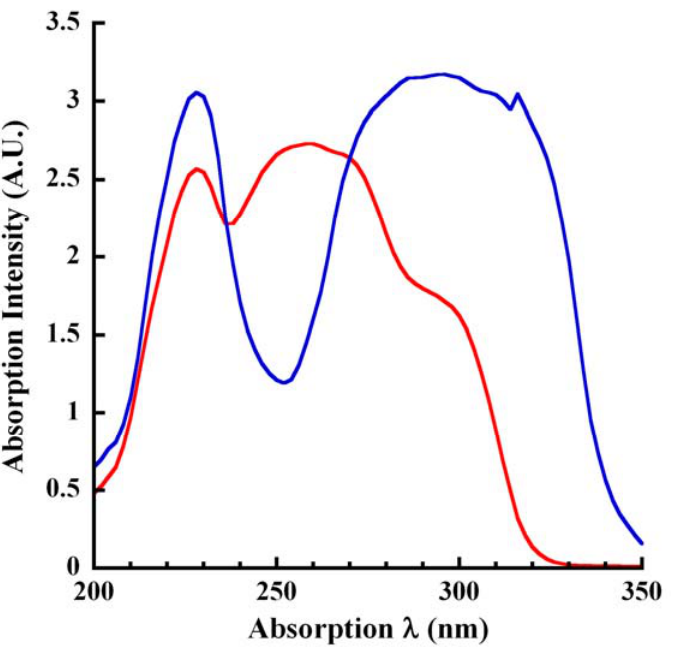
Figure 1. Absorption spectra of unmodified CA. The absorption of CA (100 μ L Vt ; 250 μ M final) was measured at ~25 °C under acidic (citrate buffer, pH 4.5; red tracing) and basic (250 mM KOH; blue tracing) pH conditions in a 96-well UV-transparent microplate. Absorption was scanned over the wavelength range of 200 to 350 nm in 2 nm intervals. Absorption profiles were corrected for background from the vehicle (pH 4.5 buffer or 250 mM